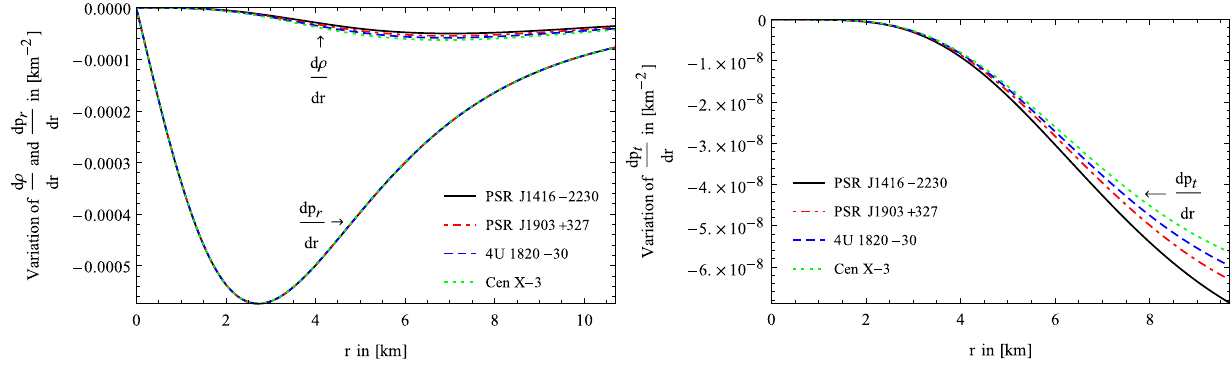
Fig. 3 The variation of ingredients of energy density, radial pressure (left panel) and tangential pressure (right panel) with the radial coor- dinate r for experimental statistics of four different compact stars. For